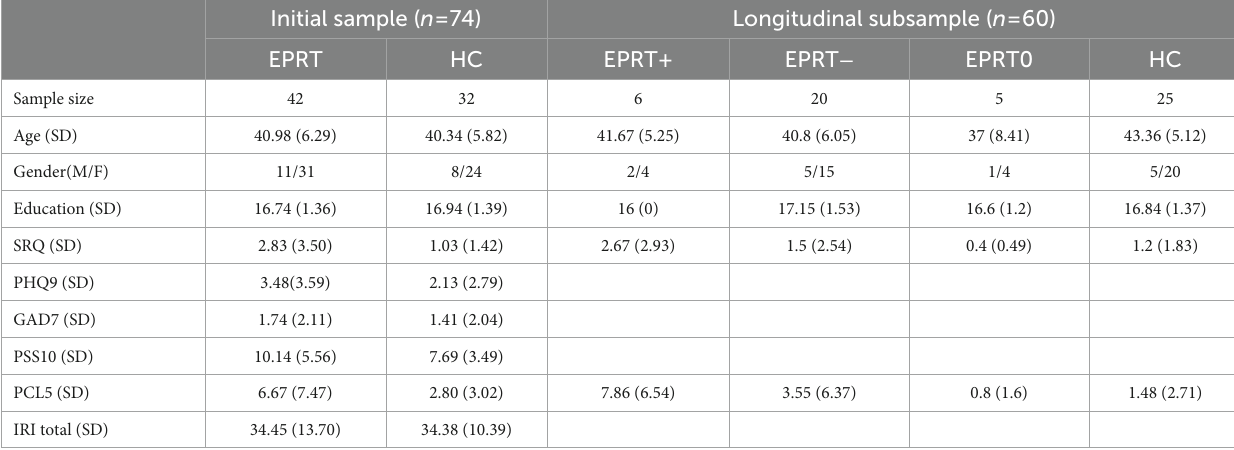
TABLE 1 Demographics and clinical characteristics of the participants.